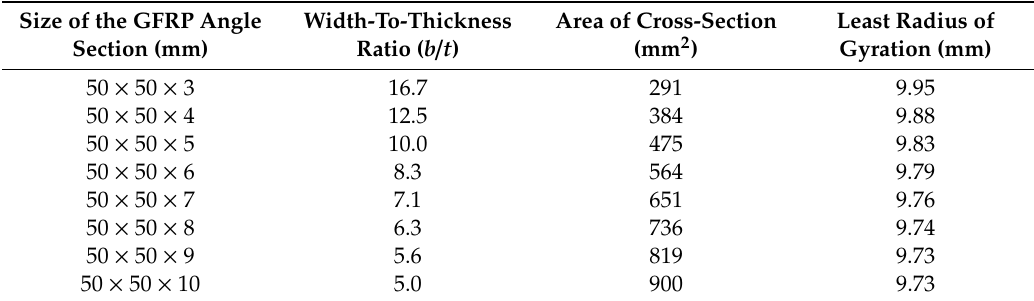
Table 4. Size of angle sections considered for parametric study.